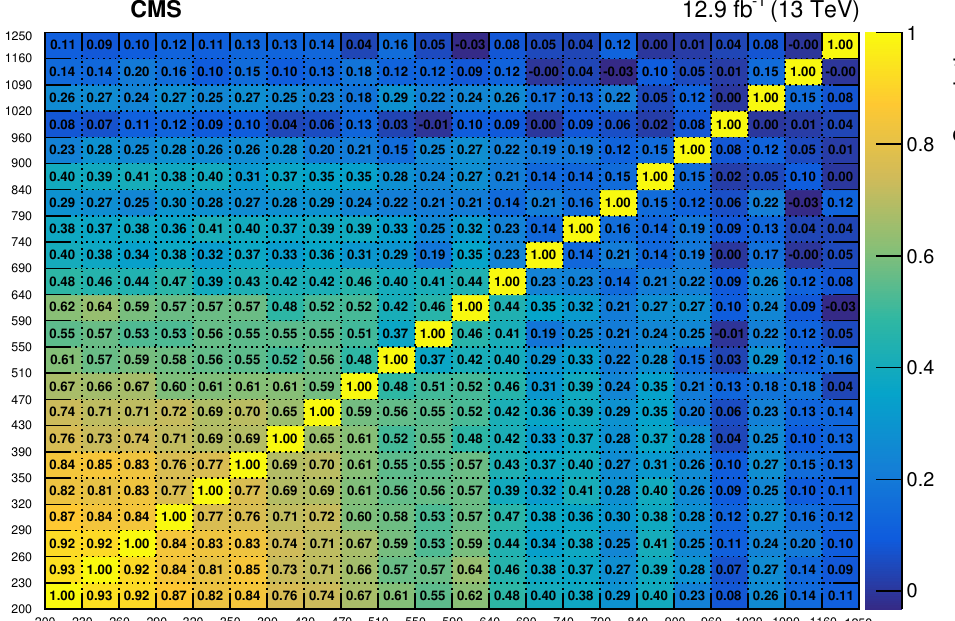
Figure 14 . Correlations between the uncertainties in the estimated background yields in all the E miss bins of the monojet signal region. The boundaries of the E miss T shown at the bottom and on the left.